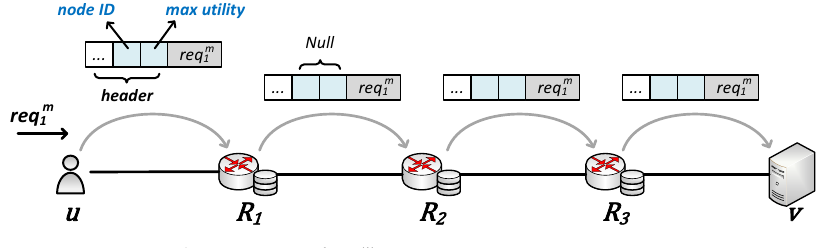
Figure 5. Forwarding process of 𝑟𝑒𝑞 1𝑚 .